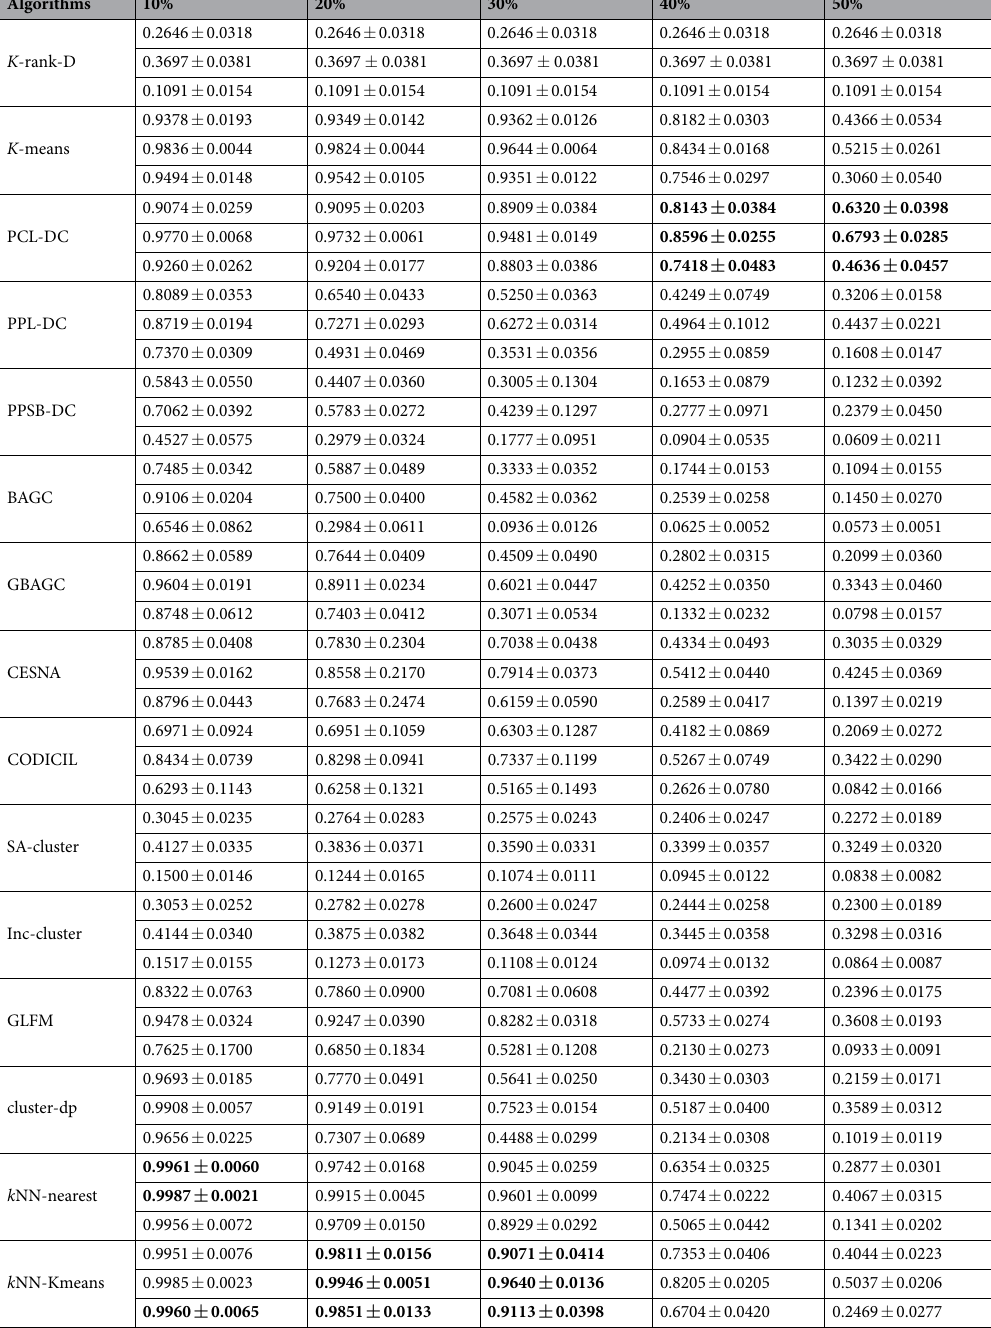
Table 2. Results on LFR networks with binary attributes, μ =